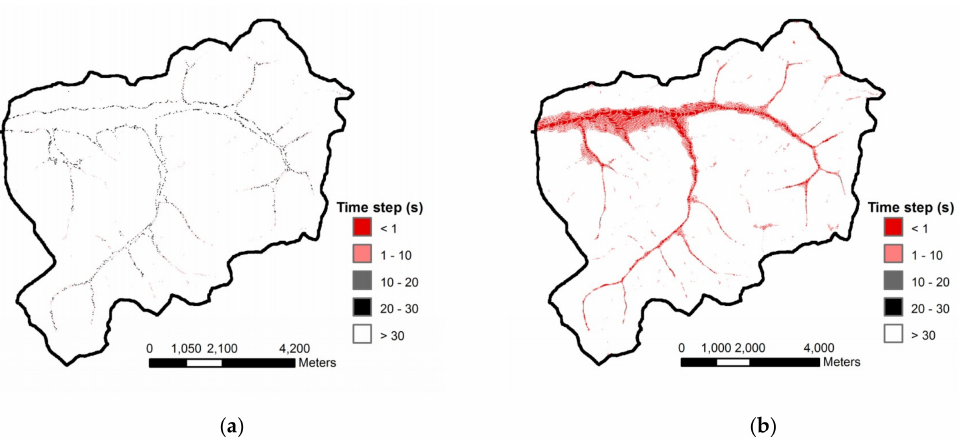
Figure 8. Distribution of the allowable time steps subject to the Hunter flow limit condition during the simulation of the storm occurring on 16 August 1968, ( a ) 2nd hour, ( b ) 20th hour.